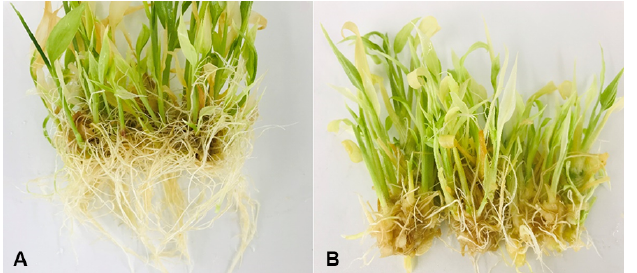
Figure 4 ( A ) Effect of IBA (indole-3-butyric acid) and NAA ( α -naphthaleneacetic acid) at the concentration of 2 mg/L on ginger plantlets. The plantlets show a high number of roots and produce microrhizomes with low fresh weights and diameters. ( B ) Effect of BAP (6-benzylamino purine) at the concentration of 2 mg/L and kinetin on ginger plantlets. The plantlets show a high number of shoots and produce microrhizomes with low fresh weights and diameters.